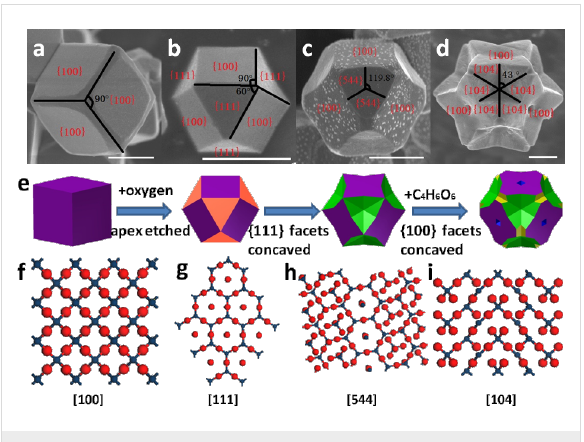
Figure 6: Morphological evolution of Cu 2 O prepared with different reaction times, (a) 30 min, (b) 60 min, (c) 90 min and (d) 120 min, all scale bars are 1 μ m. Reprinted with permission from [45]. Copyright (2014) The Royal Society of